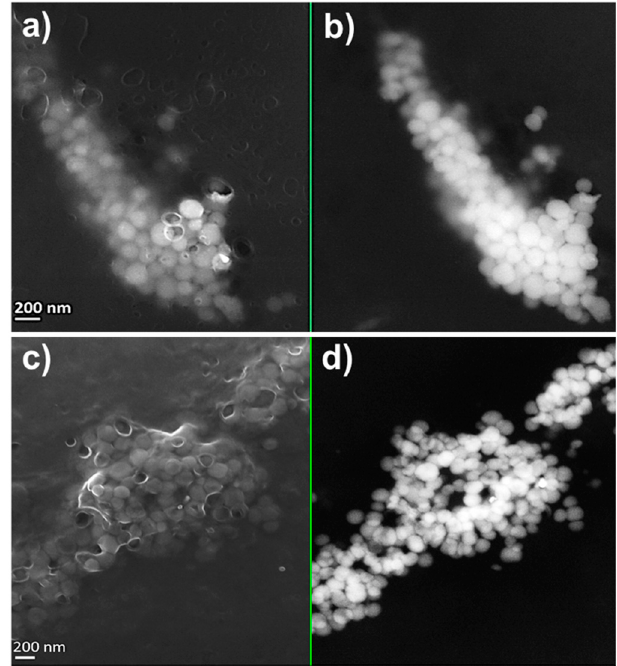
Figure 2. Scanning electron micrographs of ( a,b ) SeNPs MPV1-0.5_24_e and ( c , d ) SeNPs MPV1-0.5_120_e recovered from MPV1 cells grown for 24 h: ( a) InLens detector and ( b ) backscattered electron detector, or 120 h: ( c ) InLens detector and ( d ) backscattered electron detector in the presence of 0.5 mM SeO 32 − .